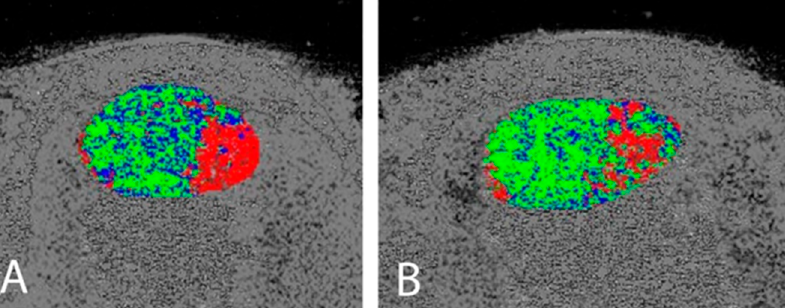
Figure 3. Pre- ( A ) and post-operative ( B ) UTC examinations demonstrating an increase in organised (green) tissue in the post-operative ( B ) Achilles tendon.